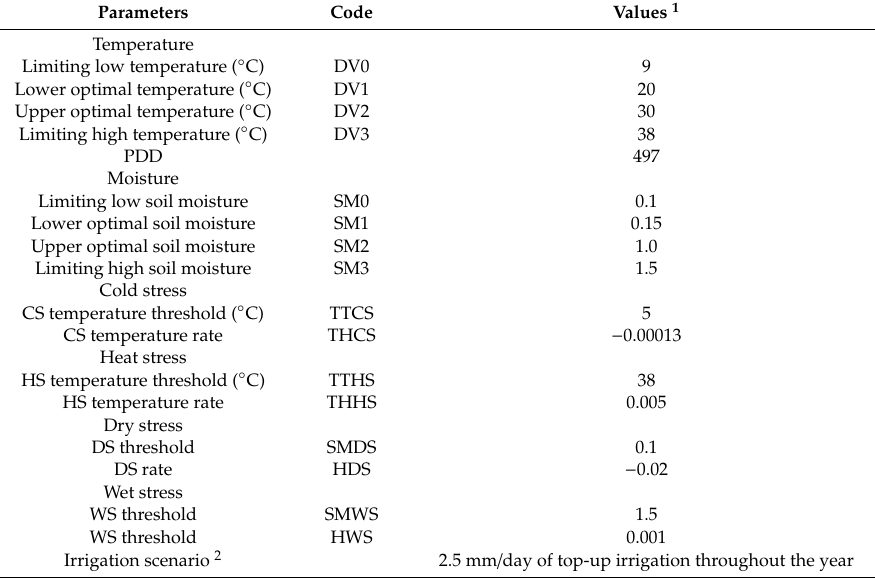
Table 1. Parameter values for simulating the potential distribution of potato tuber moth in